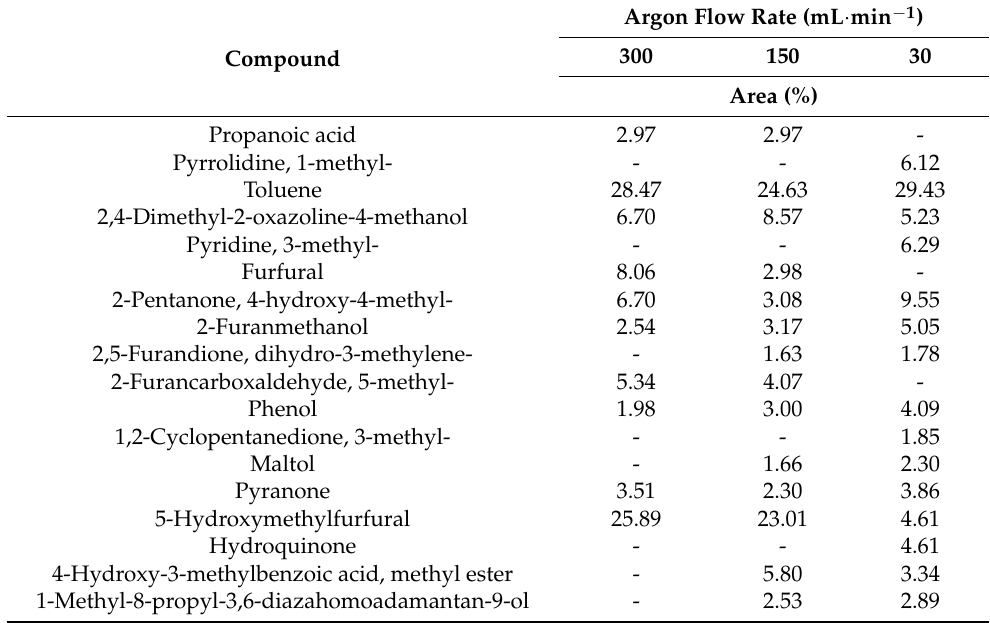
Table 6. Compounds detected in orange waste bio-oils chromatograms and their relative area percentages using different argon flow rates during the